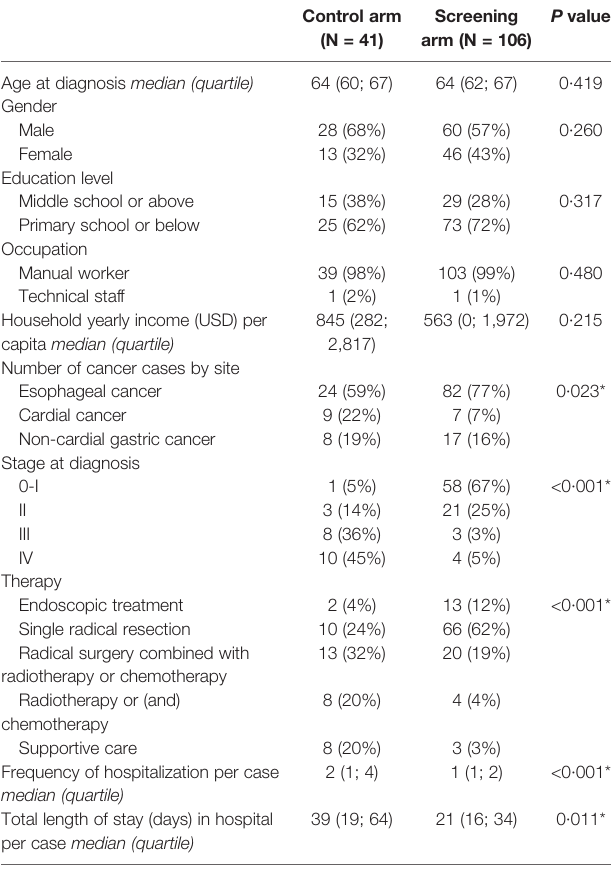
TABLE 1 | Social-demographic and clinical features of subjects in the “ Perfect Cohort ” from the ESECC a trial.